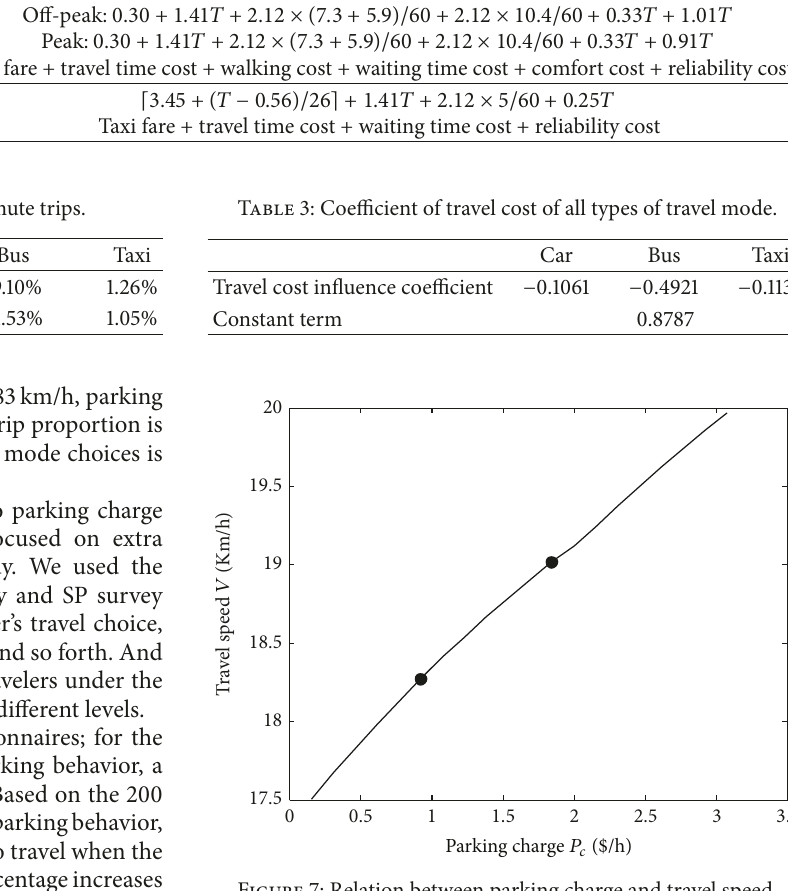
Figure 7: Relation between parking charge and travel